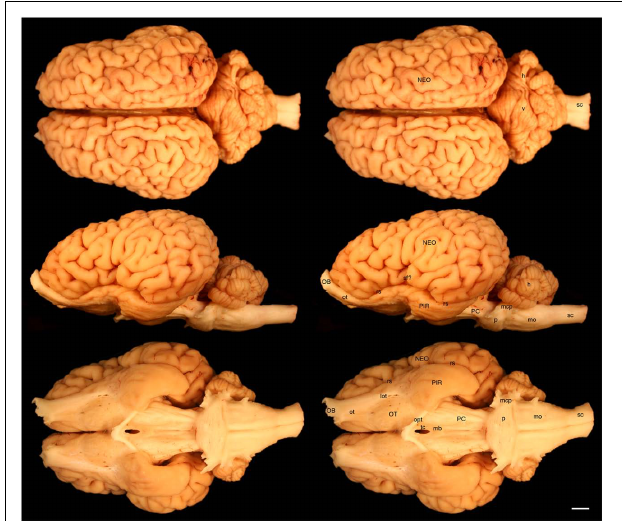
FIGURE 2 | Dorsal, lateral, and ventral views of the brain of the white rhinoceros ( Ceratotherium simum ). Left column of images unlabelled. Right column of images, duplicates of those on the left with a number of specific structures labeled. Note the typically mammalian appearance of the brain in terms of the major anatomical subdivisions. Also note the very asymmetrical appearance of the vermal portion of the cerebellum. Scale bar = 1 cm. h, hemispheric portion of cerebellum; lot, lateral olfactory tract; mb, mammillary bodies; mcp, middle cerebellar peduncle; mo, medulla oblongata; NEO, cerebral neocortex; OB, olfactory bulb; opt, optic tract; OT, olfactory tubercle; ot, olfactory tract; p, pons; PC, cerebral peduncle; PIR, piriform cortex; rs, rhinal sulcus; sc, spinal cord; sf?, potential sylvian fissure; tc, tuber cinereum; v, vermal portion of